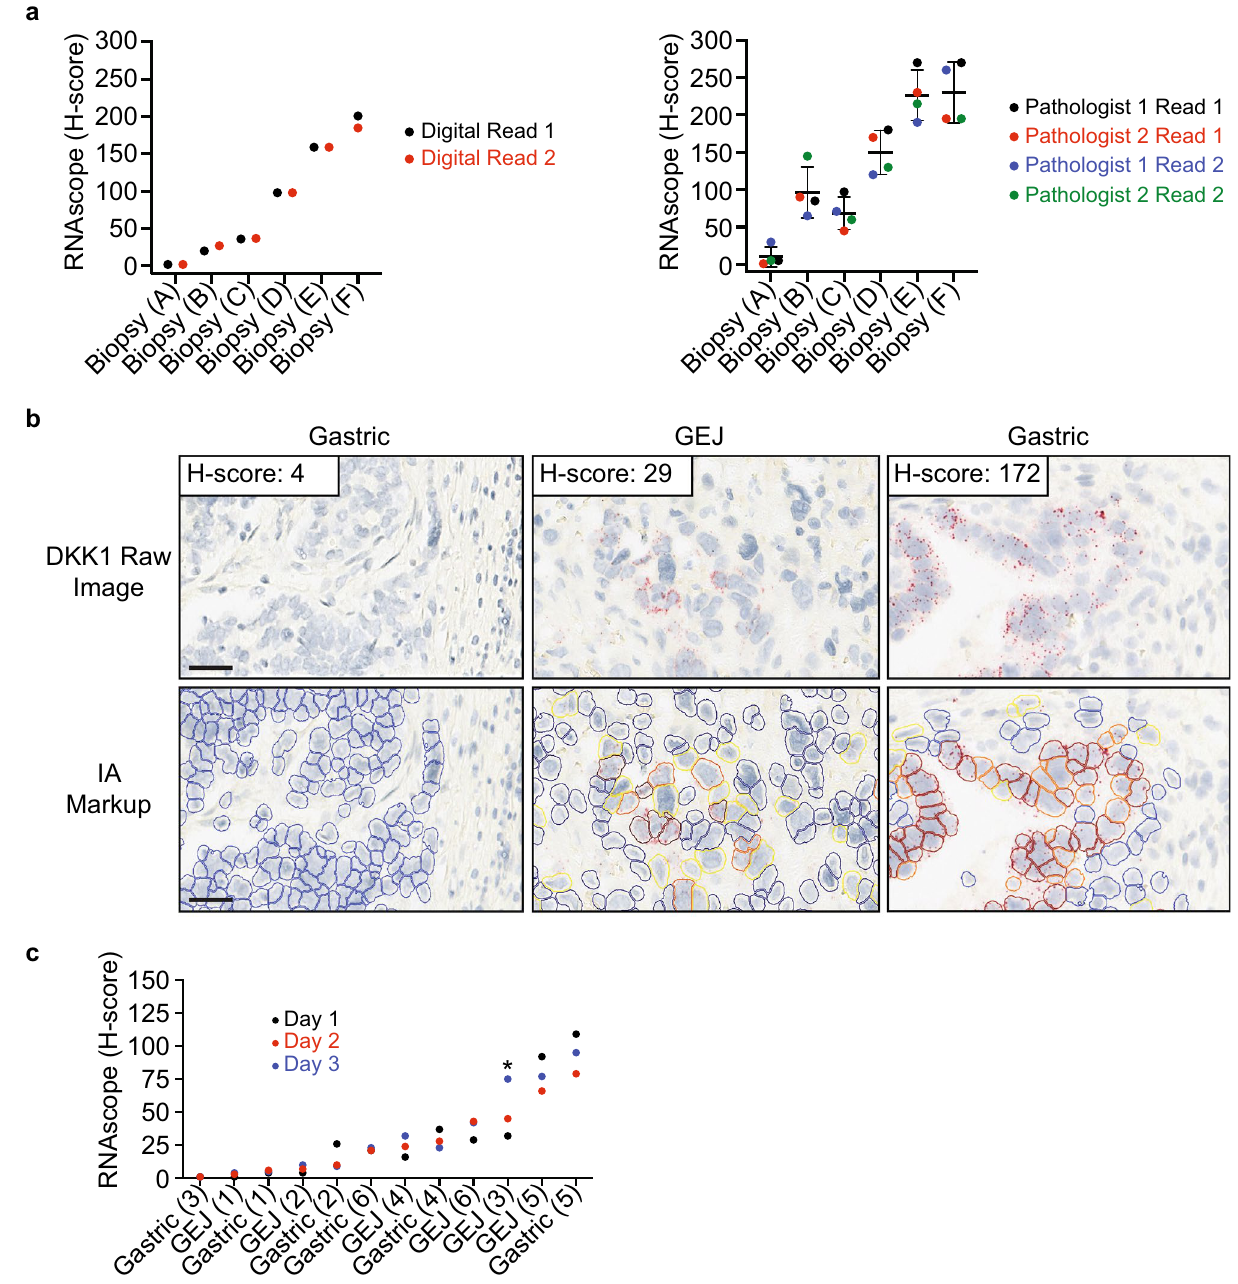
Figure 4. Validation of the digital image analysis algorithm to quantify DKK1 RNAscope signal. ( a ) Six gastric/gastroesophageal junction tumor biopsies with a range of DKK1 expression were stained for DKK1 by RNAscope. Images were scored in duplicate using an image analysis solution from Flagship Biosciences (left graph) and an H-score (range 0–300) was calculated as described in the methods. The same images were scored manually in duplicate with a one week washout period by two separate pathologists (right panel). Mean and standard deviation are shown. ( b ) Representative images from 3 tumor resections with no, low, and high DKK1 signal and the image analysis markup are shown. Markup up colors correspond to the following; blue indicates tumor cells with no DKK1 signal, yellow represents tumors cells with low signal (1–3 dots), orange selected tumors cells have medium signal (4–9 dots), and red identifies tumors cells with high signal (10 + dots). Stromal cells which are not highlighted by the algorithm are not scored. Image analysis (IA). Scale bar: 10 μm. ( c ) Images from replicate DKK1 staining conducted on 3 different days were analyzed and H-scores were quantified. All replicates were required to be in the same bin category or within an H-score of ± 20 if discordant binning occurred. Bins were defined as, negative signal (H-score = 0), low signal (H-score < 34), and high signal (H-score ≥ 35). Asterisk indicates a resection that did not meet the precision